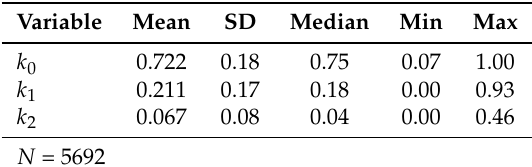
Table 10. Summary of Naive k 0 , k 1 , and k 2